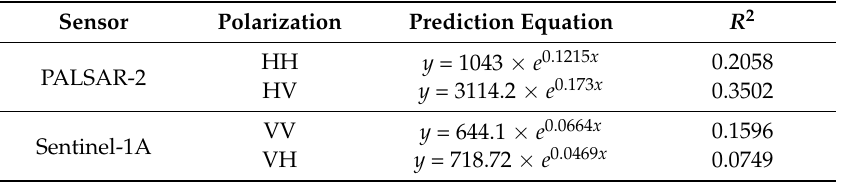
Table 9. Summary of non-linear correlation between AGB and individual polarization.